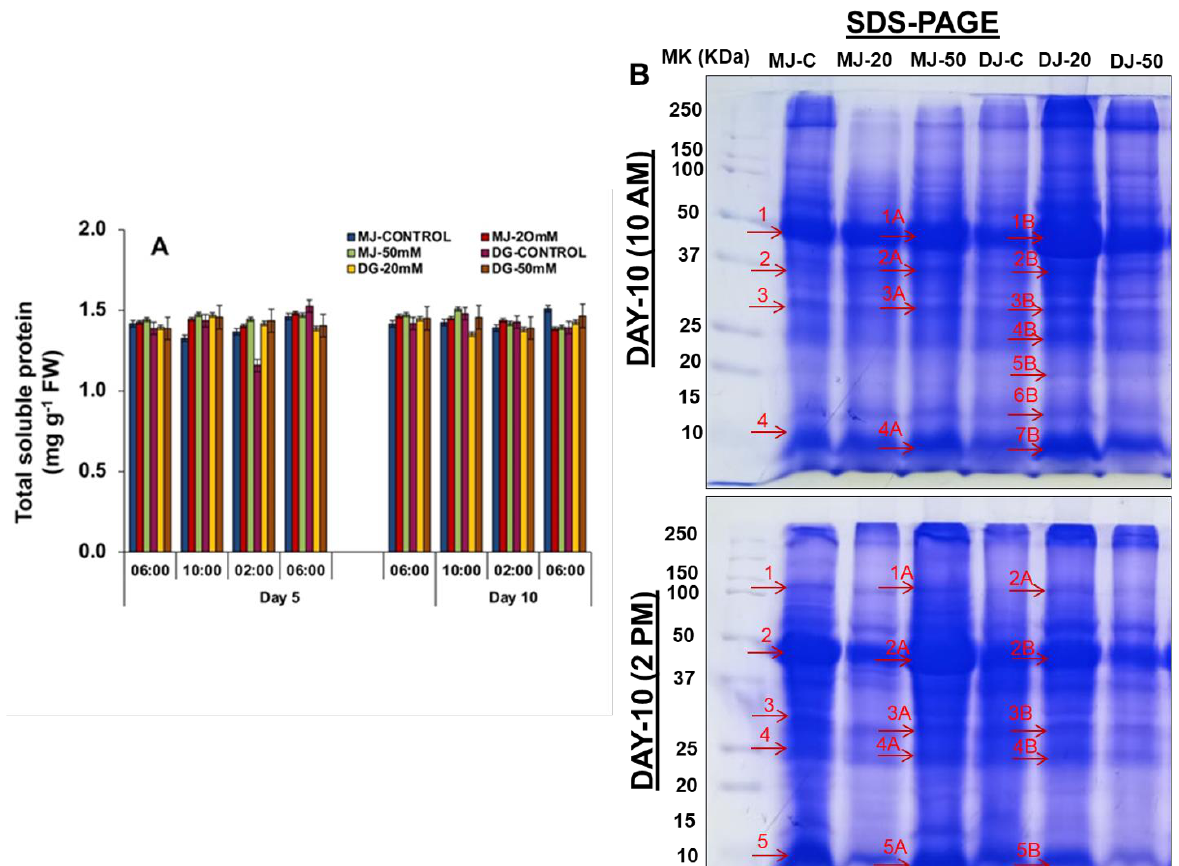
Figure 11. ( A ) Total soluble protein content, and ( B ) SDS-PAGE in spinach genotypes Delhi green (DG) and Malav Jyoti (MJ). Results are presented for the controls (MJ control; DG control), 20 mM of NaCl treatments (MJ-20 mM; DG-20 mM), and 50 mM of NaCl treatments (MJ-50 mM; DG-50 mM). Sampling was performed (on the basis of the circadian cycle) at 4 h intervals which corresponded to the exact times of 10 am, and 2 pm on day 10 of salinity stress. Vertical bars indicate the mean ± S.E. for n = 3. In bar graph (A), days 5 and 10 are shown separately but colors of the bars containing same samples at different hours remain the same. The red arrows with numbers indicate the upregulation or downregulation of specific proteins bands along with their controls.